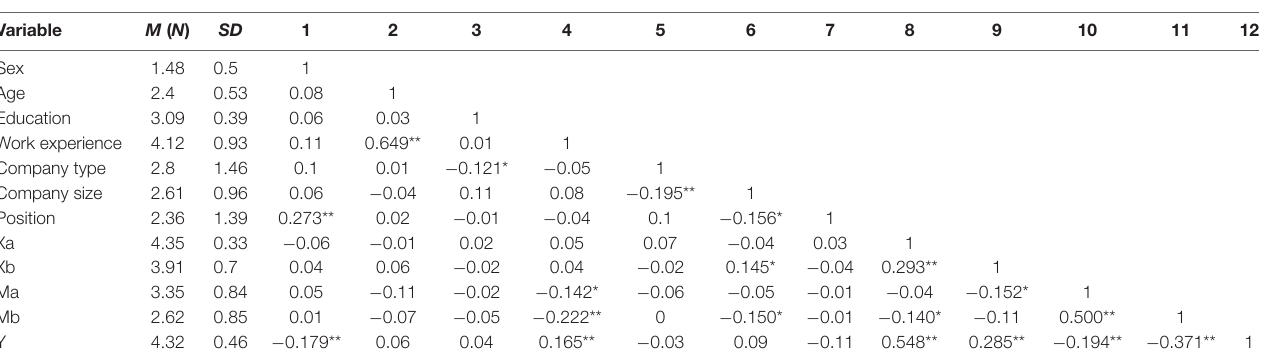
TABLE 2 | Descriptive statistical analysis and correlations ( N =